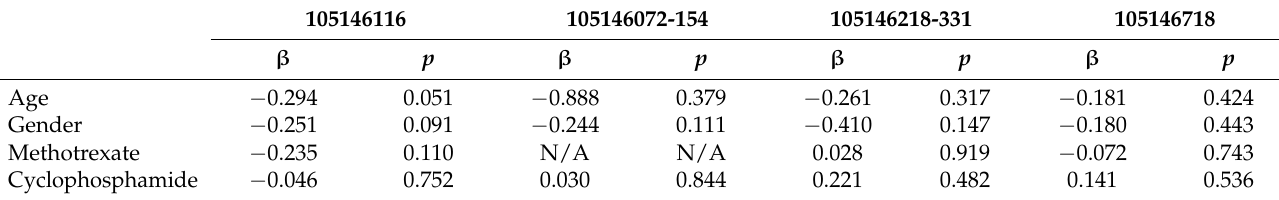
Table 6. Multivariate regression of factors relevant to TET2 -promoter methylation